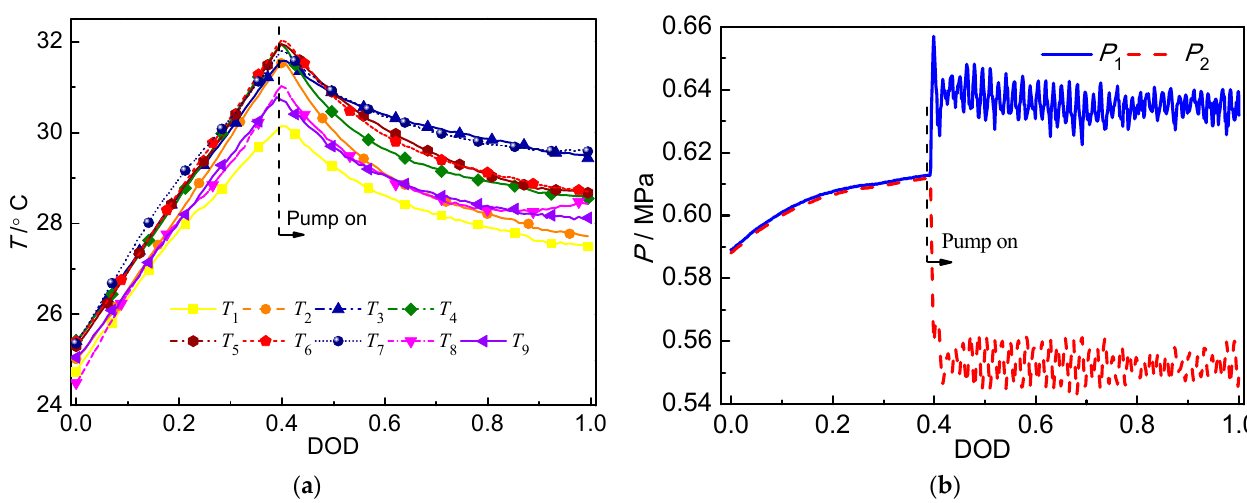
Figure 4. Evolution of ( a ) the monitored temperatures and ( b ) the inflow and outflow pressures during 1.0 C discharging. The pump operates at 50 Hz if on.